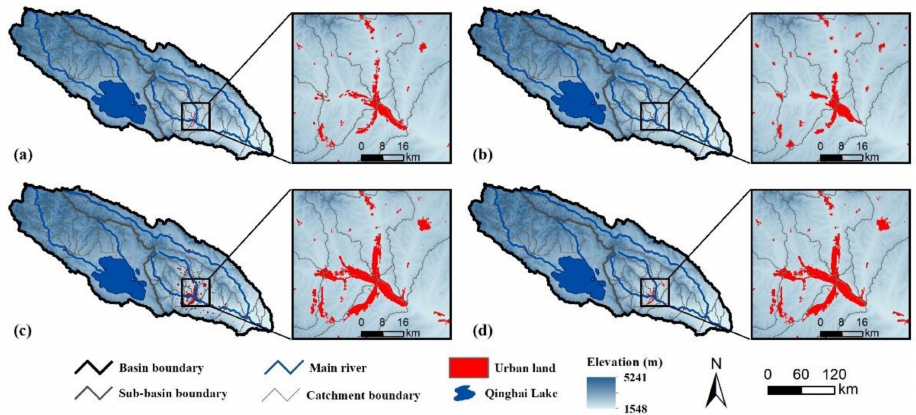
Figure 6. A simulation of urban expansion from 2000 to 2018. ( a ) Actual urban pattern in 2010, ( b ) simulated urban pattern in 2010 (Kappa = 0.65), ( c ) actual urban pattern in 2018, ( d ) simulated urban pattern in 2018 (Kappa =